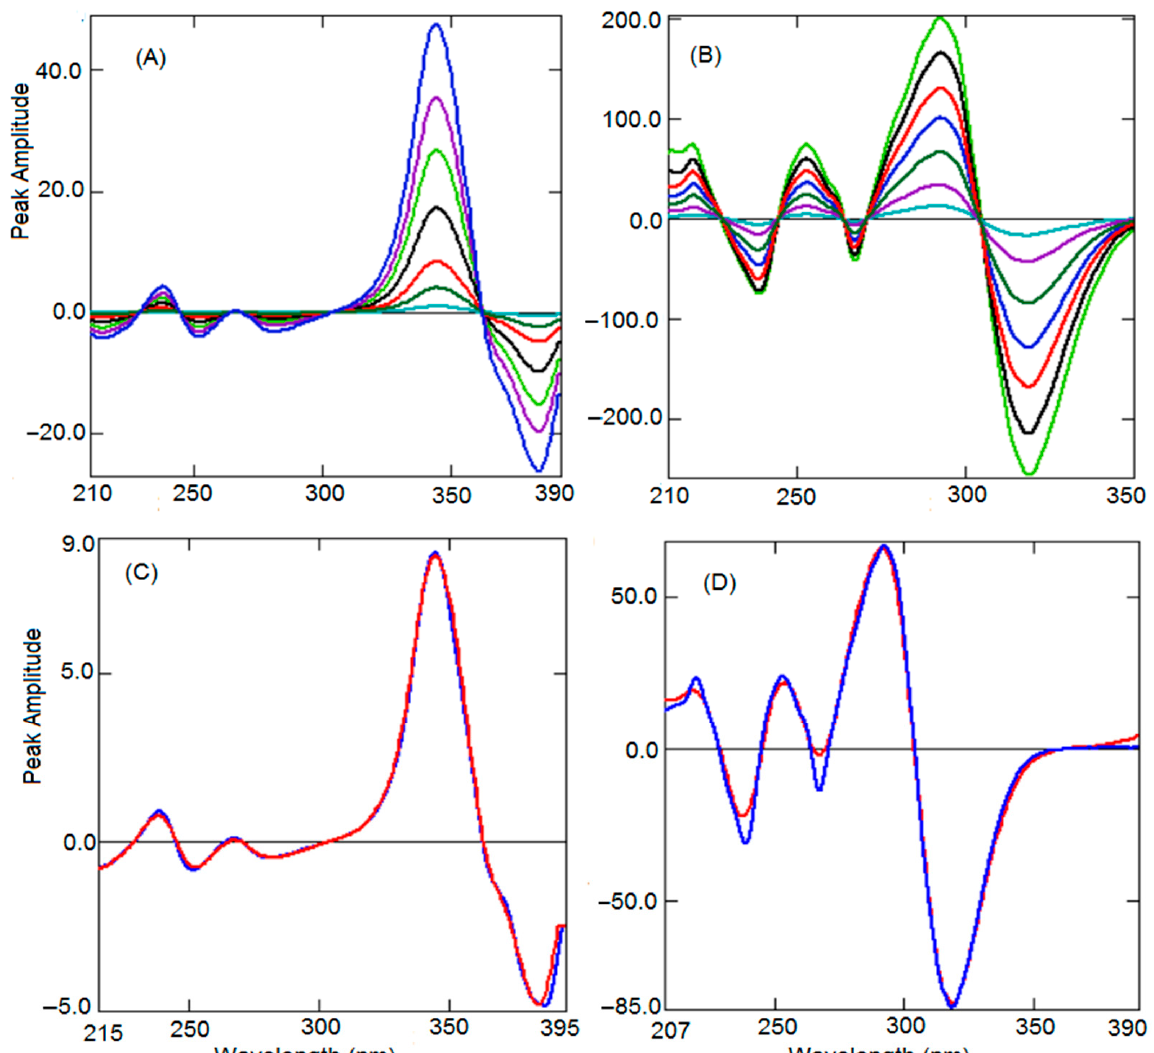
Figure 4. Ratio first derivative spectra of BEN (0.5–10 µg mL − 1 ) ( A ). Ratio first derivative spectra of TEL (1–30 µg mL − 1 ) ( B ). Comparison of ratio first derivative spectra of pure (Red) BEN ( C ) and TEL ( D ) with the mixture (Blue).